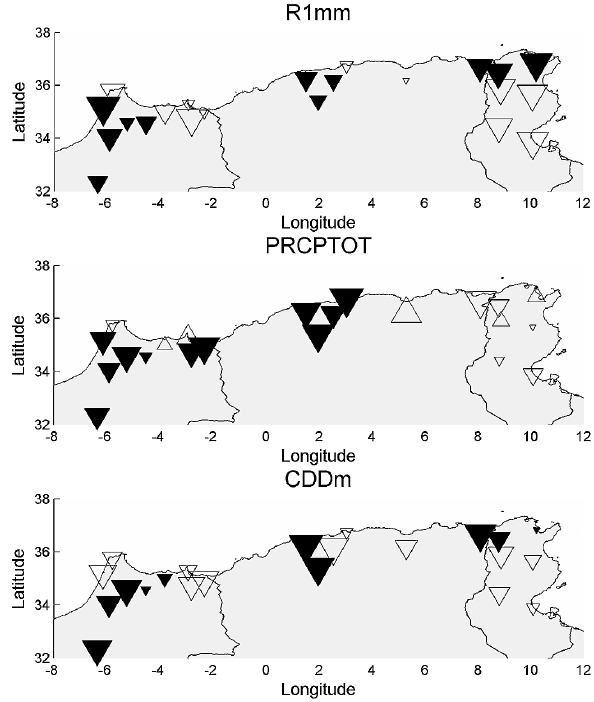
Fig. 6. Maps of the long-term trends detected for the indices R1mm, PRCPTOT and CDDm. The size of the triangles is proportional to the Sen slopes estimated on the full length of the time series. The triangles filled with black are the stations where the trend is signifi- cant at the 5% level according to the Mann–Kendall test. The actual values of the Sen slopes are in Table